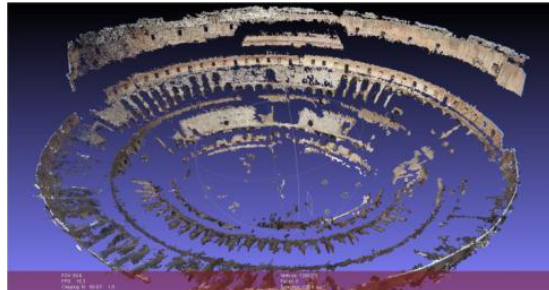
Figure 13. Automated restitution of 3D points by SfM